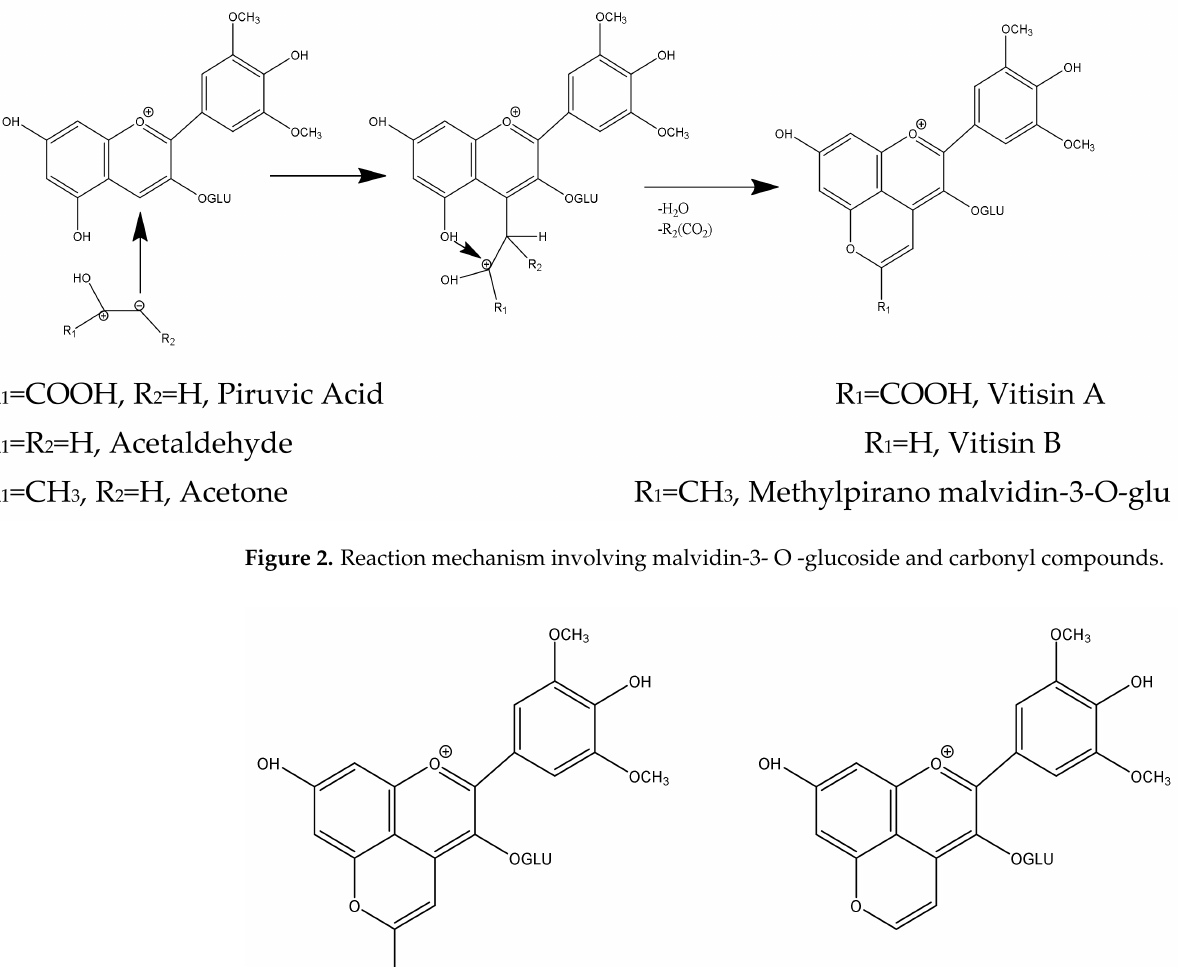
Figure 3. Chemical structure of Vitisin A and Vitisin